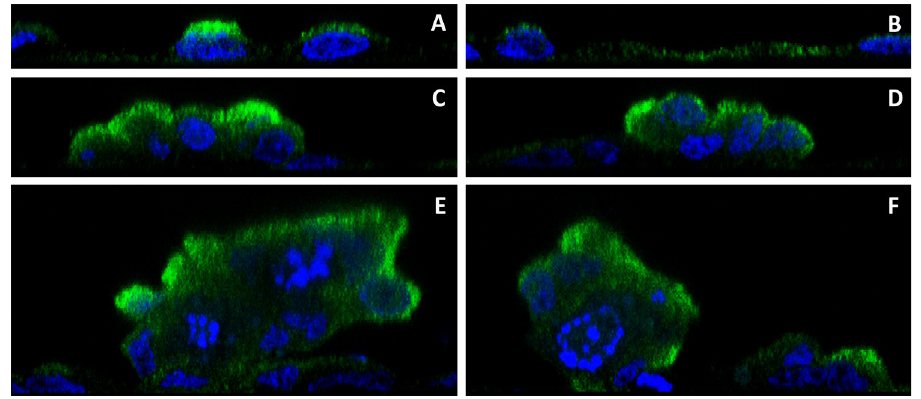
Fig 3. Orthogonal images of MT-3 localization. MT-3 (green) and nuclei (blue) are seen in orthogonal sections along the x-axis (A, C and E) and y-axis (B, D and F) for same 3 fields shown in Fig 1. The non-doming monolayer (A and B), the moderately tall dome (C and D) and the taller dome structure (E and F) are all shown.